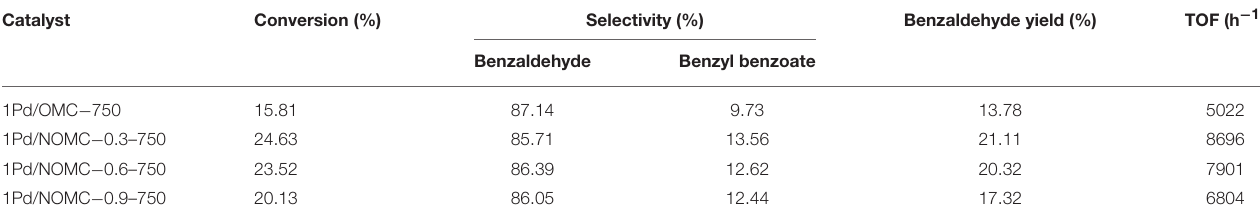
TABLE 2 | Catalytic performance of NOMC Supported Pd catalysts with different N-doping amount a . Catalyst Conversion (%) Selectivity (%) Benzaldehyde yield (%) TOF (h − 1 ) Benzaldehyde